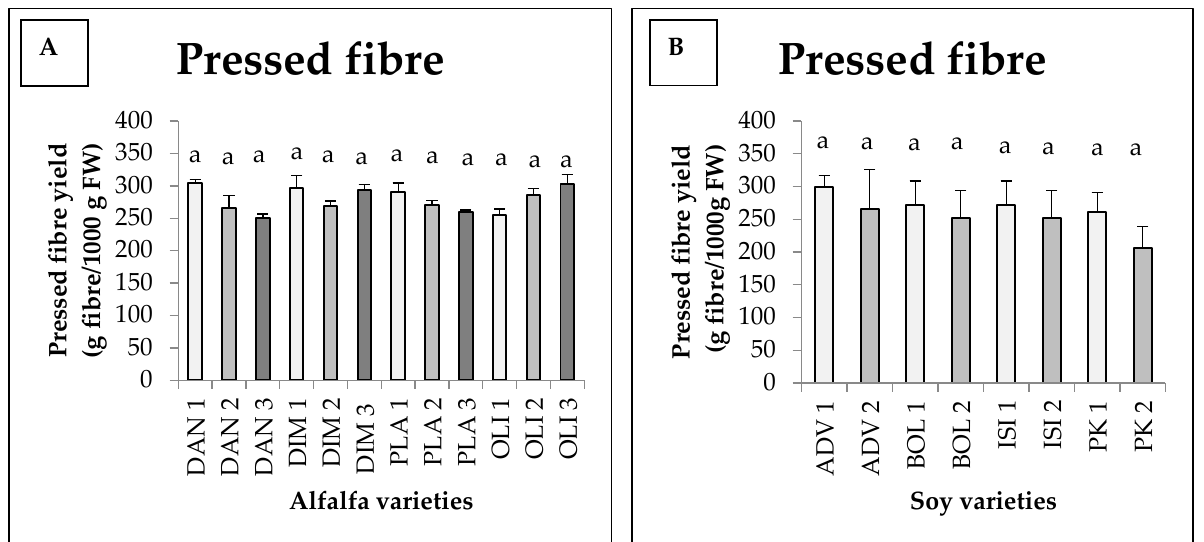
Figure 1. Average press fibre yields of different alfalfa ( A ) and soy ( B ) varieties as a function of harvesting time (+SD). Different letters above the columns refer to significant differences ( p ≤ 0.05). FW = Fresh weight.